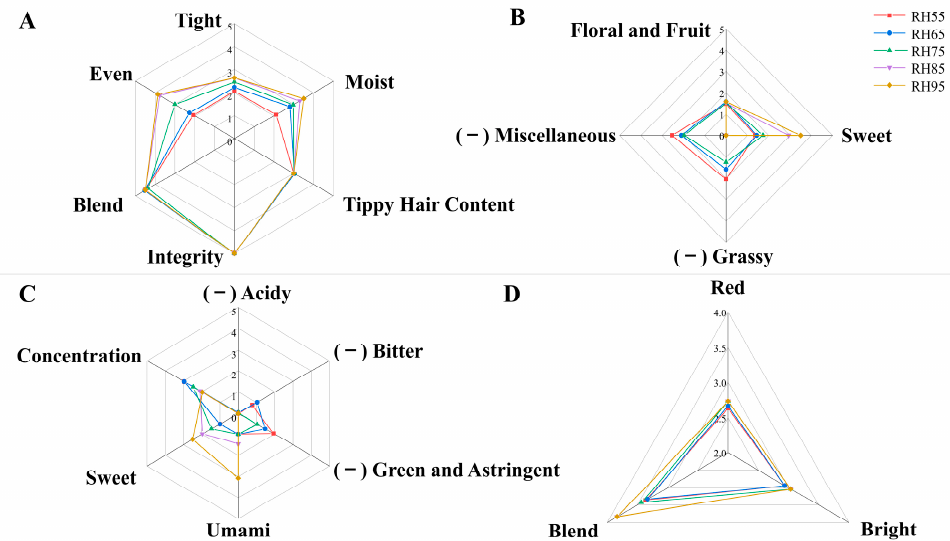
Figure 2. QDA analysis diagrams for the appearance ( A ), aroma ( B ), taste ( C ) and infused leaf ( D ) of congou black tea under di ff erent fermentation humidity conditions, with di ff erent colored lines for di ff erent samples.